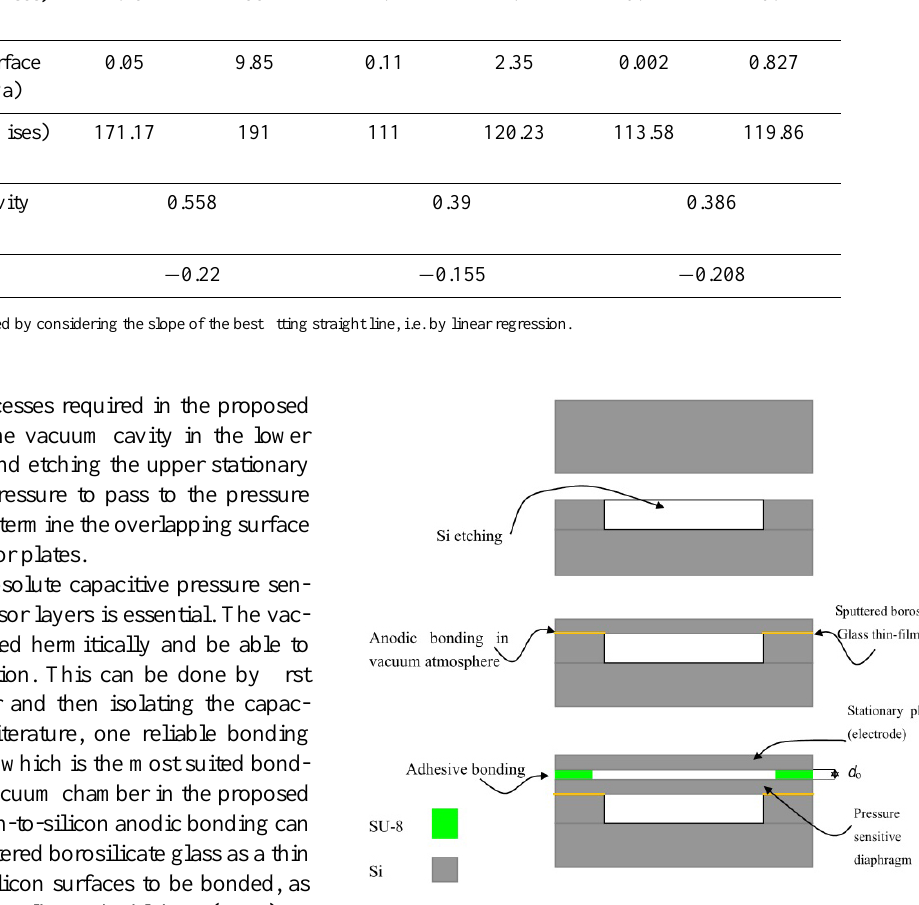
Figure 20. A suggested micro-machining process flow of the de- signed MEMS pressure